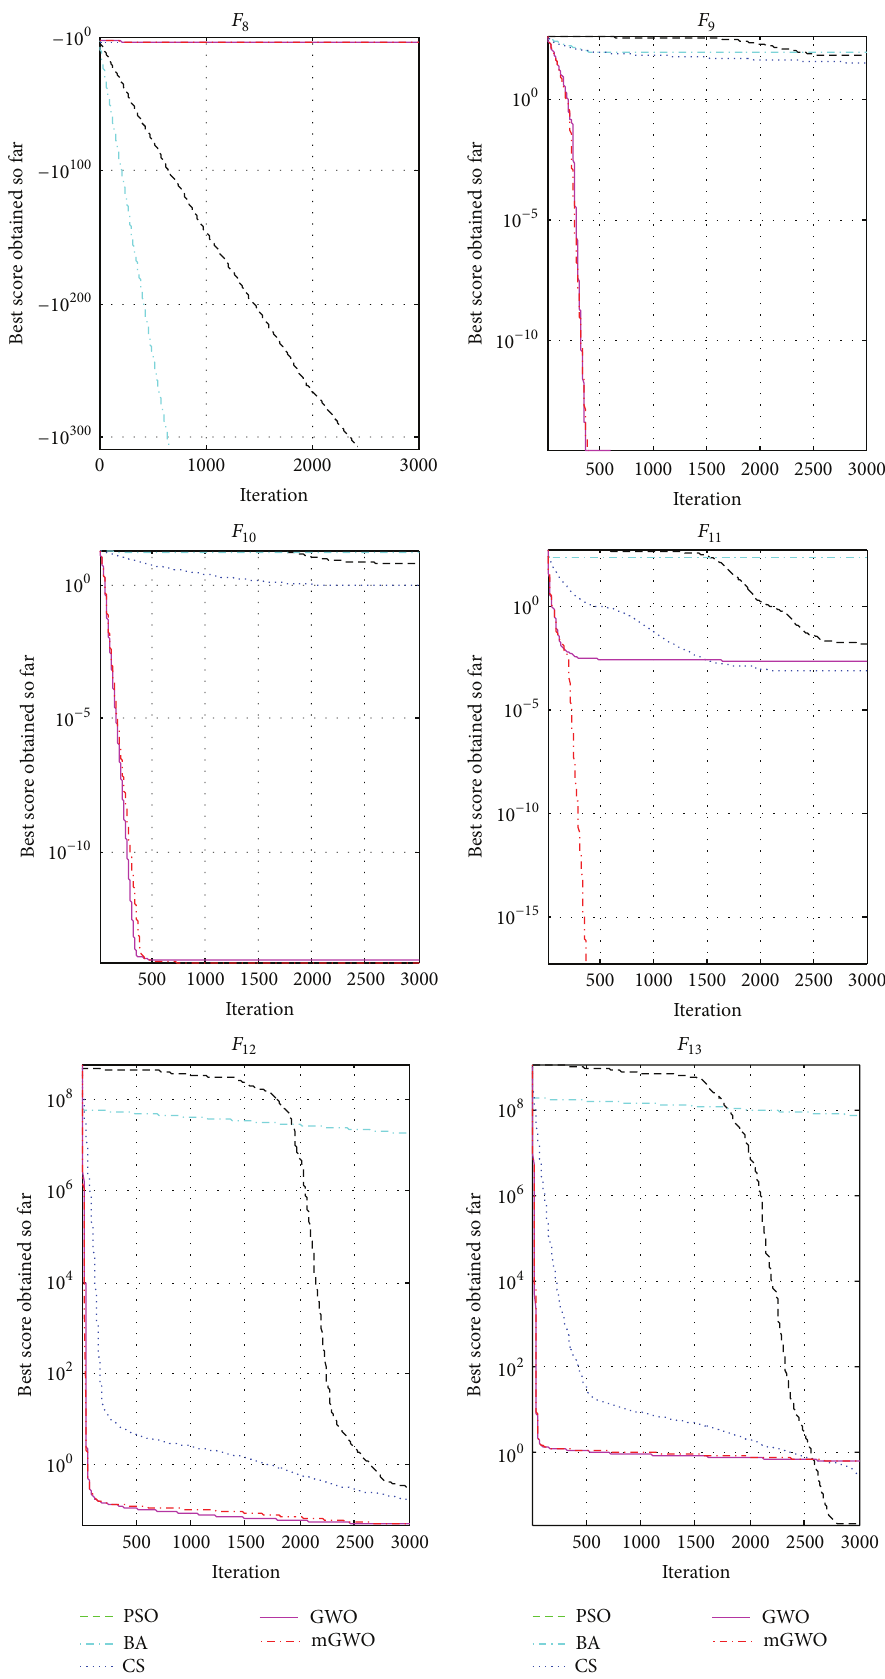
Figure 3: Convergence graph of multimodal benchmark